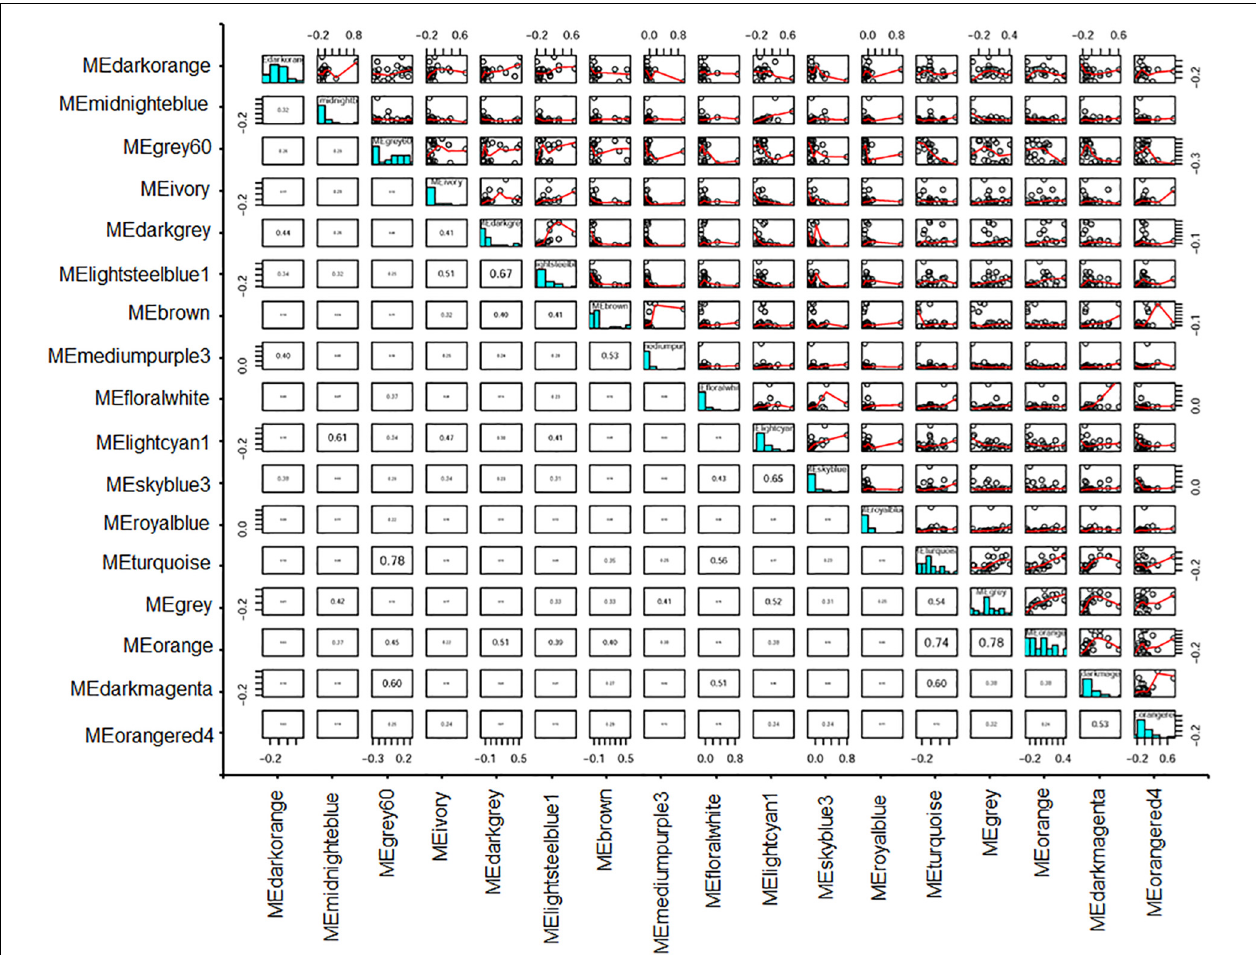
FIGURE 10 | Heatmap plot of correlations between module eigengenes. Values in each cell represent the correlation coefficients between the adjacent